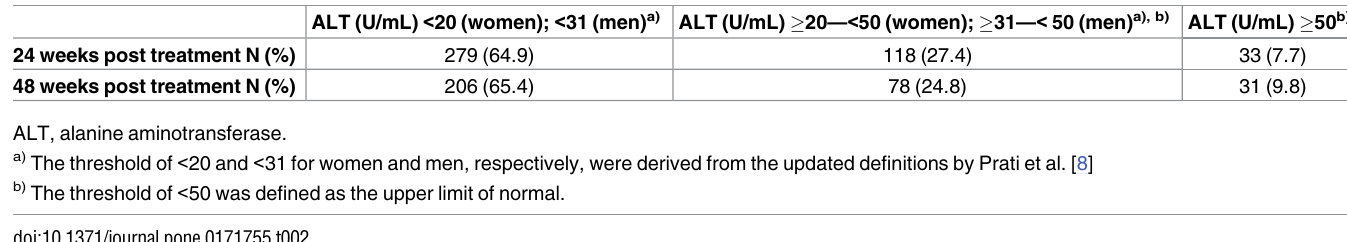
Table 2. Frequency of elevated ALT levels after HCV eradication in cohort